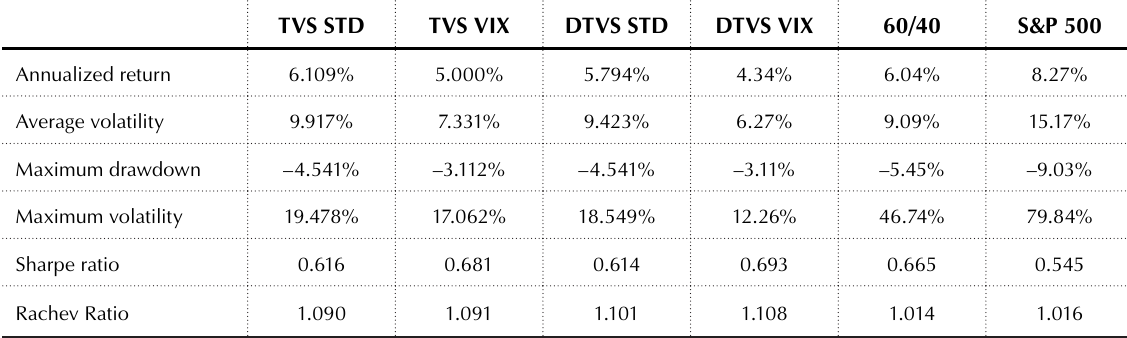
Table 2. Portfolio statistics for rebalancing buffer